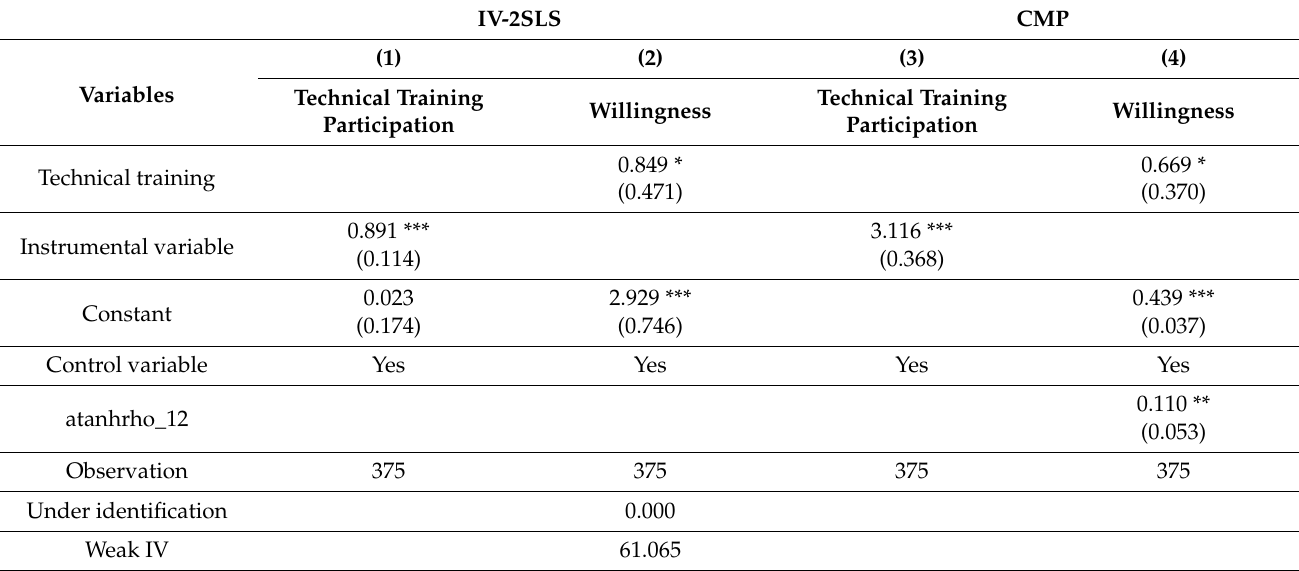
Table 4. Addressing endogeneity: instrumental variable estimation.